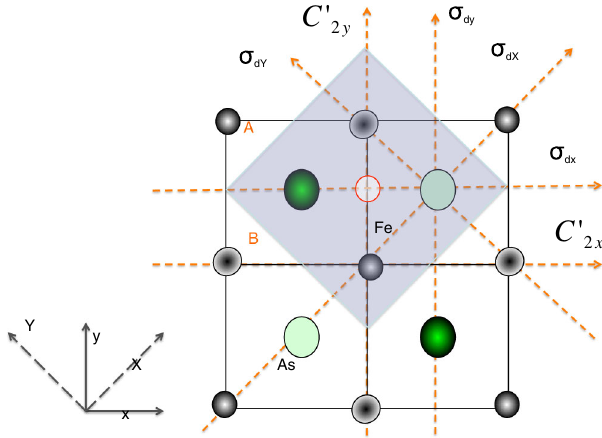
FIG. 1. Sketch of the lattice structure of a trilayer Fe-As(Se) unit. Notations used in this paper for axis directions, reflection symmetries, and two sublattices are